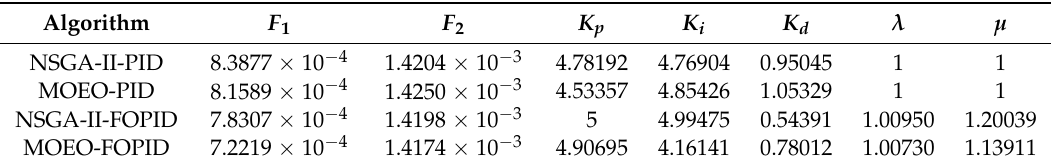
Figure 5. Comparison of Pareto fronts for PID/FOPID controllers obtained by NSGA-II and MOEO for the microgrid under the minimum values of HI. Table 5. Best FOPID/PID controller parameters and performance obtained by MOEO and NSGA-II under the minimum values of HI.